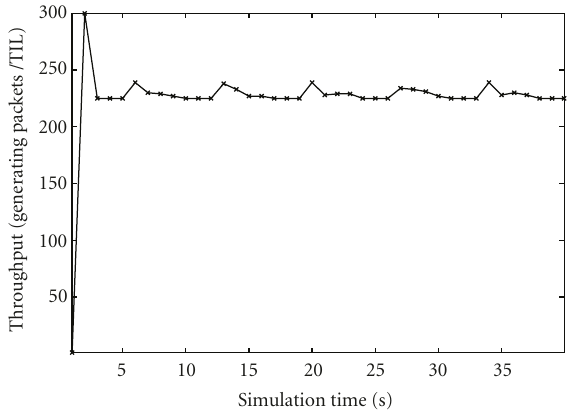
Figure 13: Generating packets ( N = 25, G = 4, nodes speed = 10m/s).